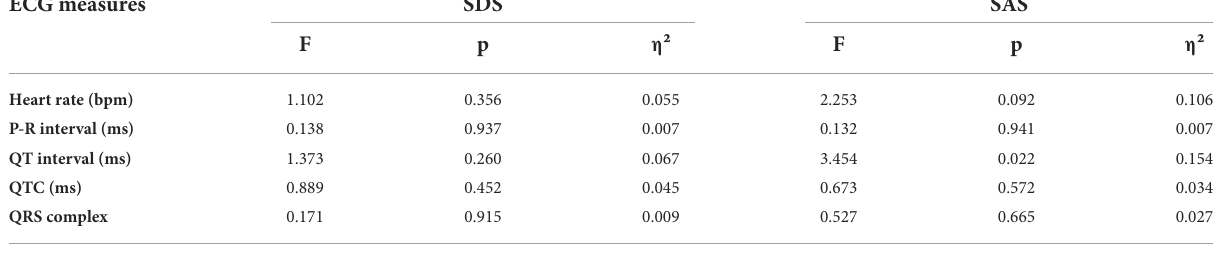
TABLE 2 Differences in ECG measures of depression and anxiety severity.